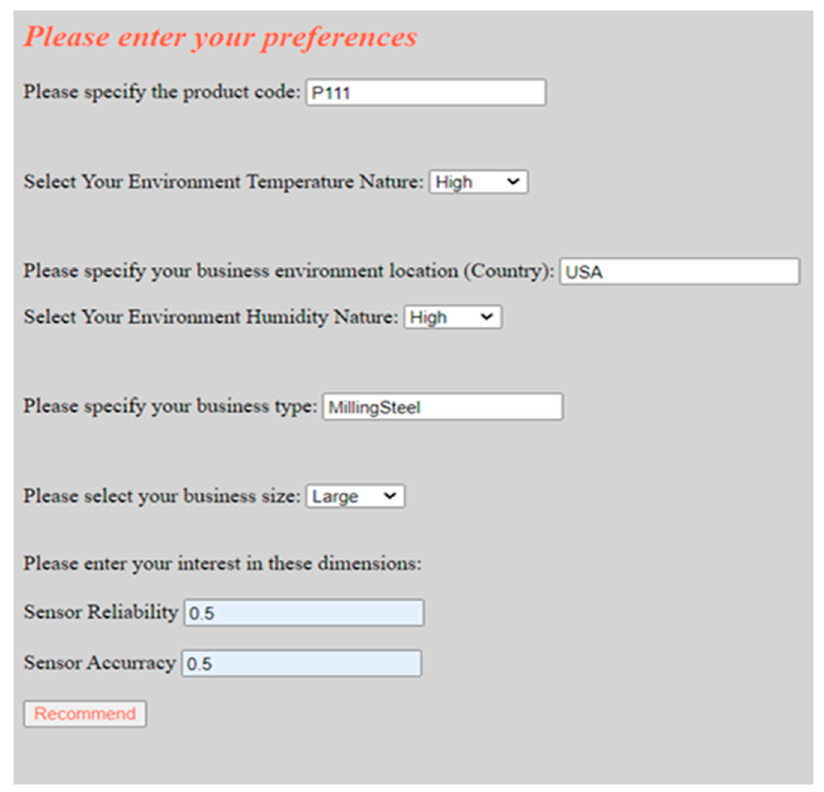
Figure 8. The user interface for the recommender system’s knowledge acquisition.